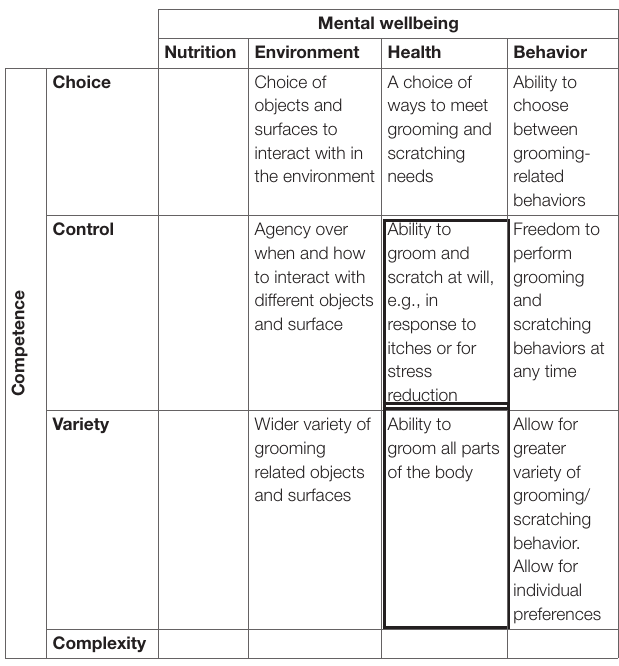
TABLE 3 | WtC design opportunities matrix used to identify opportunities for enabling cows’ self-grooming